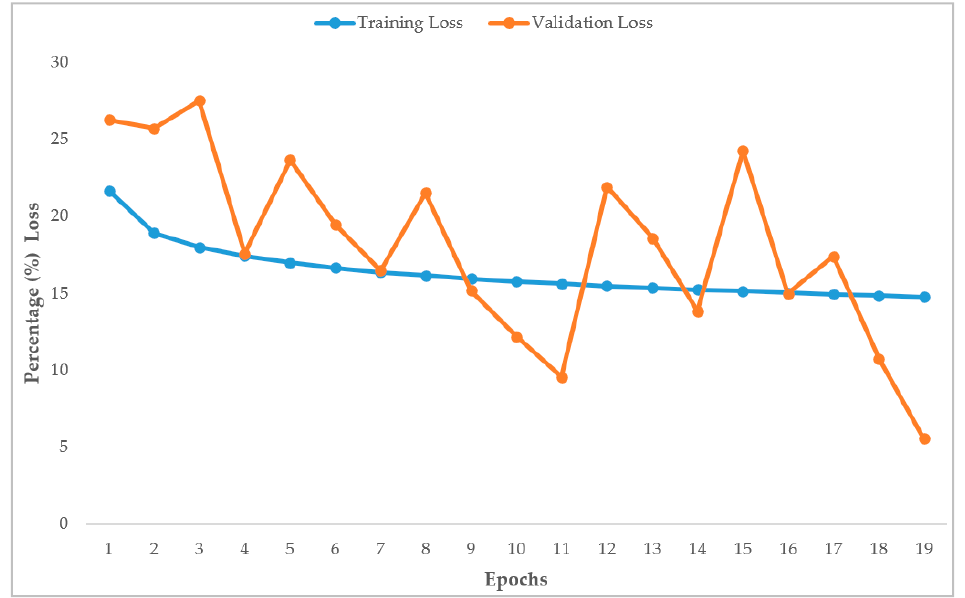
Figure 13. Training and validation loss percentages versus training epochs for the custom YOLOv3 model.